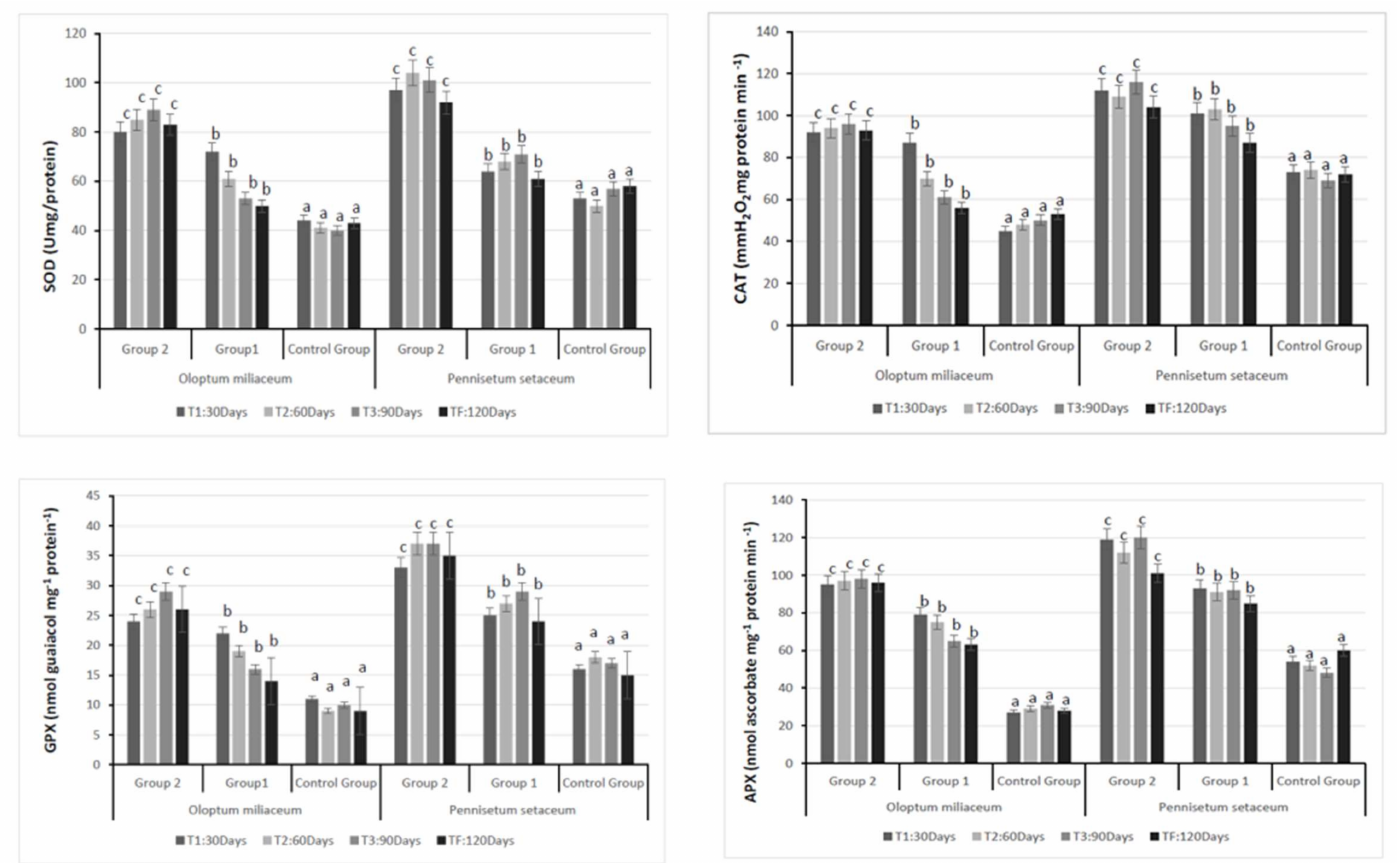
Figure 1. Antioxidant activity of SOD (Umg / protein), CAT (nmol H 2 O 2 mg − 1 protein min − 1 ), GPX (nmol guaiacol mg − 1 protein min − 1 ) and APX (nmol ascorbate mg − 1 protein min − 1 ) in leaves of Oloptum miliaceum and Pennisetum setaceum to Group 1, 2 and Control Group after 30 (T1), 30 (T2), 90 (T3) and 120 (TF) days. Values represent mean ± SE. Di ff erent letters indicate means that are significantly di ff erent from each other (Ducan’s test, p <